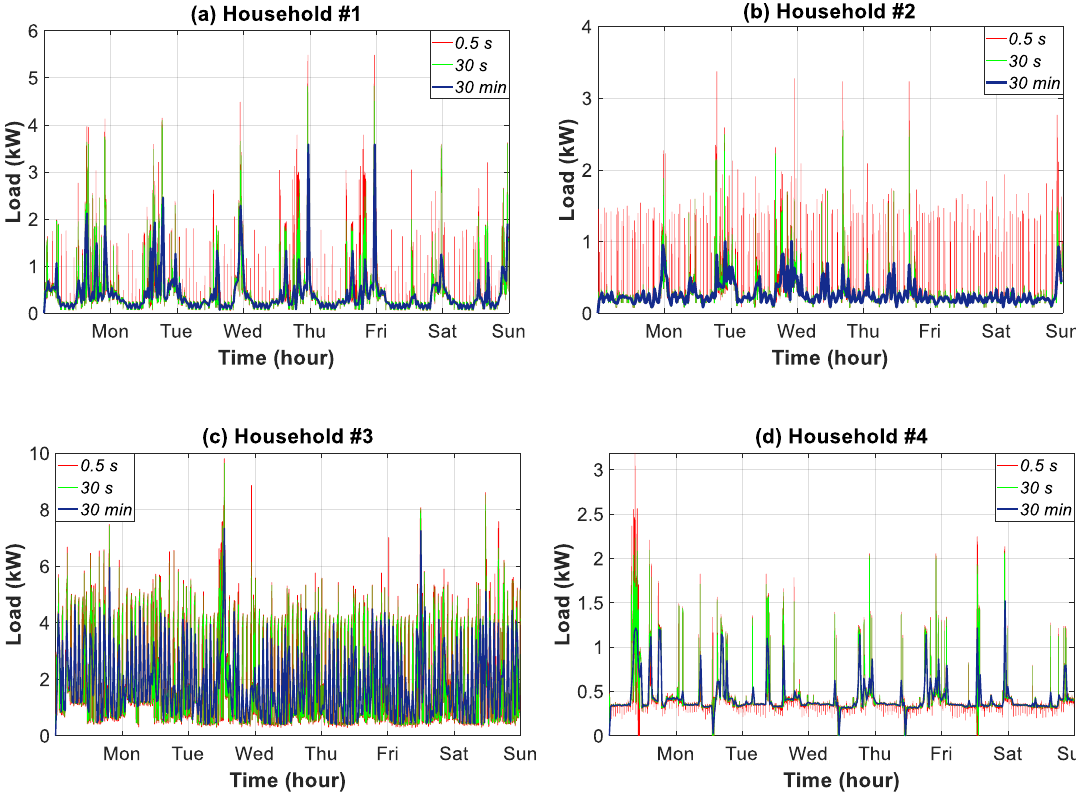
Figure 9. Weekly consumption load profile in households #1 to #4 for three data granularities.